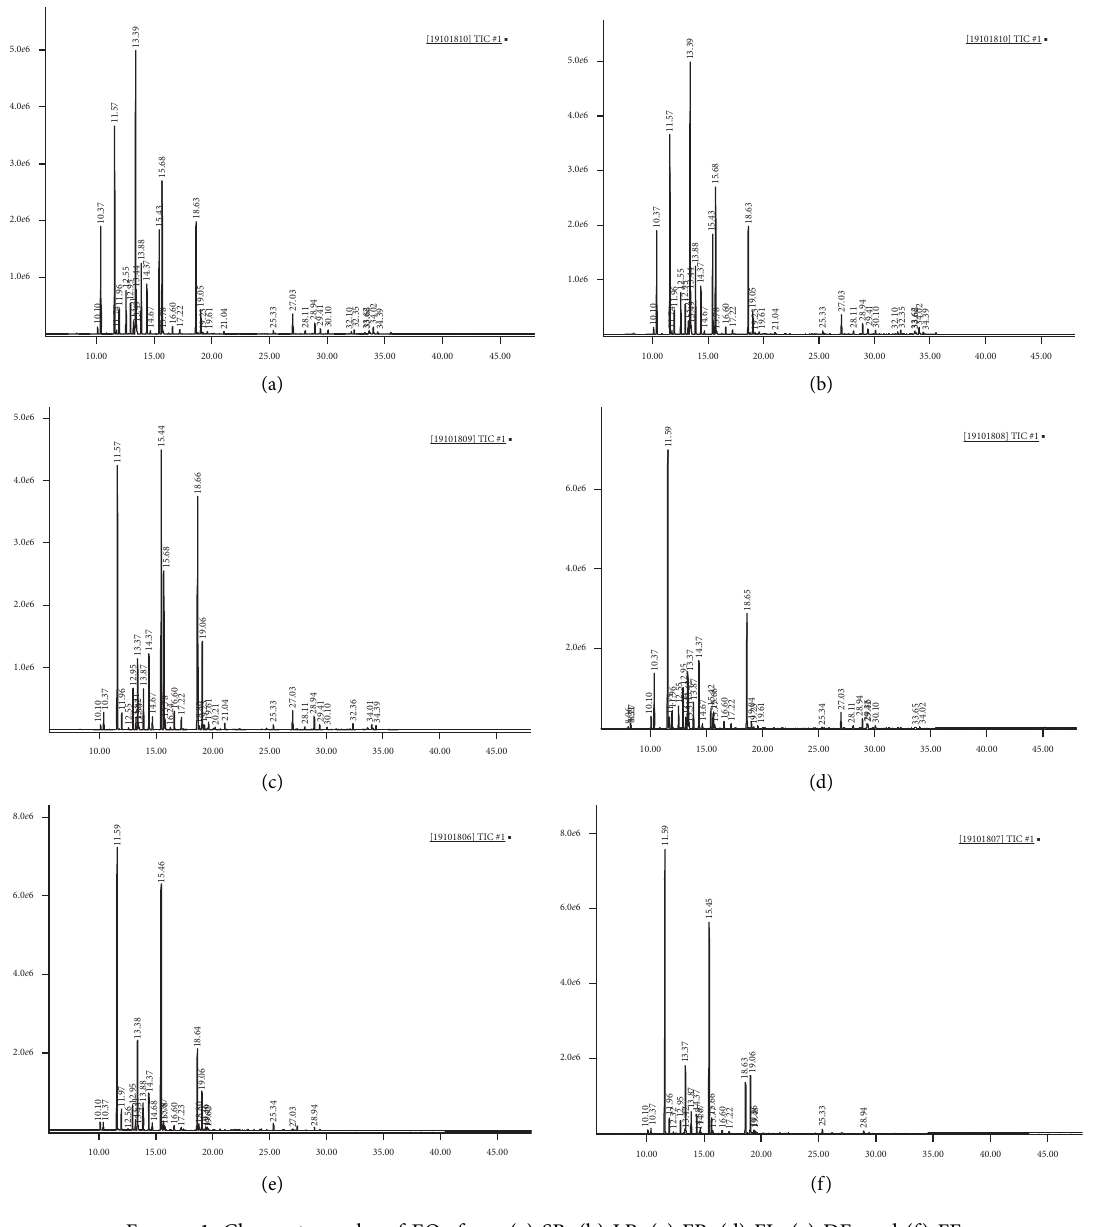
Figure 1: Chromatography of EOs from (a) SB, (b) LP, (c) FP, (d) FL, (e) DF, and (f)